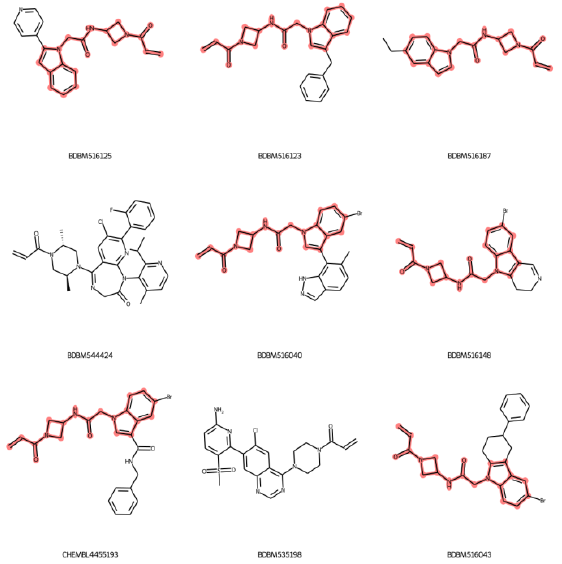
Figure 6. Chemical structures of outliers determined by the compounds whose standardized residual value exceeded ±3. The red color highlights the similar structures of the outliers.